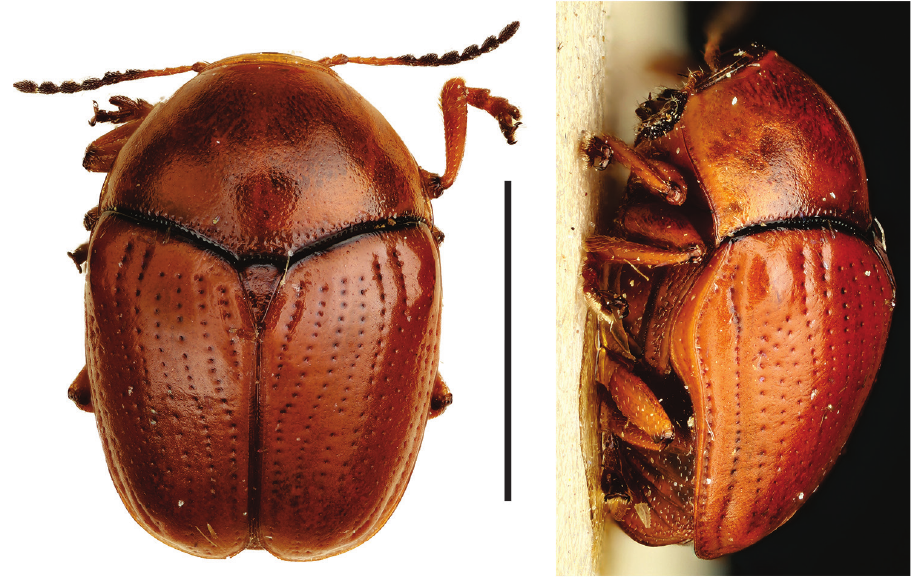
Figure 22. Lexiphanes consimilis (Suffrian) (2) , left: habitus (dorsal view), right: habitus (lateral view).